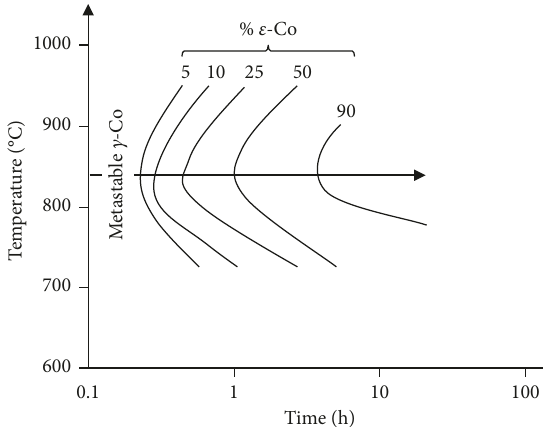
Figure 11: Isothermal TTT diagram of CoCr27Mo5C0.23, adapted from